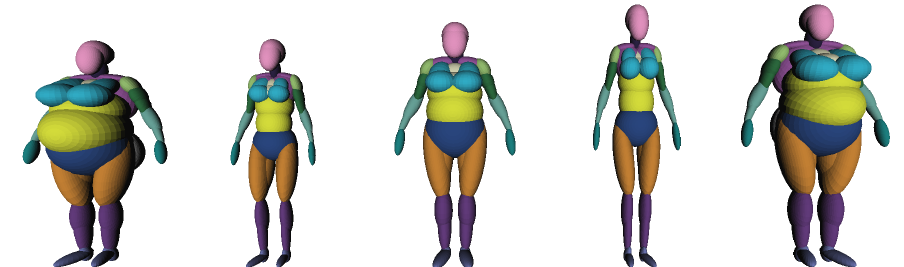
Figure 9. Set RM of Reference Mannequins as ellipsoid mannequins (no cushions) of extreme and average models. From left to right: Small Chubby, Small Slim, Average, Tall Slim, and Tall